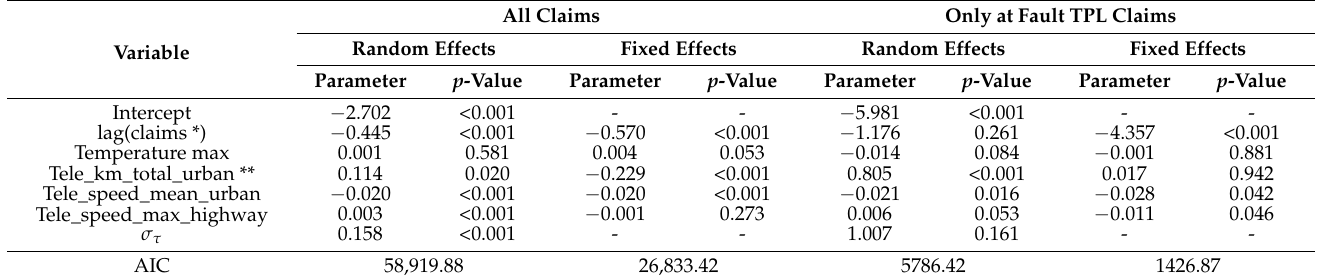
Table A6. Cross-table with the parameter estimates of random effects and fixed-effects Poisson panel data models, with p -values, for the total number of claims (left) and at-fault third party liability (TPL) claims (right) per month and per insured based on the seven observed months in 2018 and 2019. The models consider the monthly maximum daily average temperature as explanatory variable describing weather conditions.